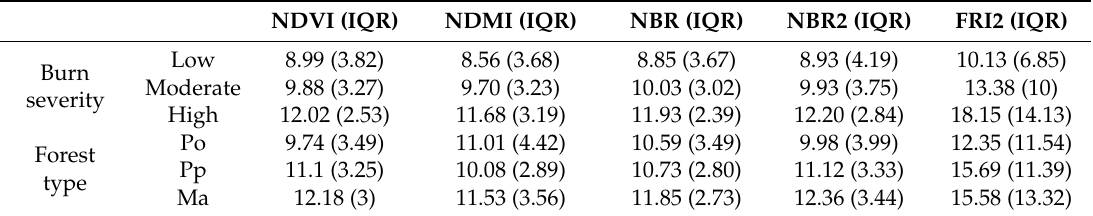
Table 3. Median values and interquartile ranges (IQRs) of years required to complete forest spectral recovery within burn severity classes and forest types by pixels with a significant recovery trend of each Relative Difference spectral vegetation index (RDSVI) ( p < 0.01). Po: pubescent oak; Pp: pine plantations; Ma: mixed manna ash and European hop-hornbeam.